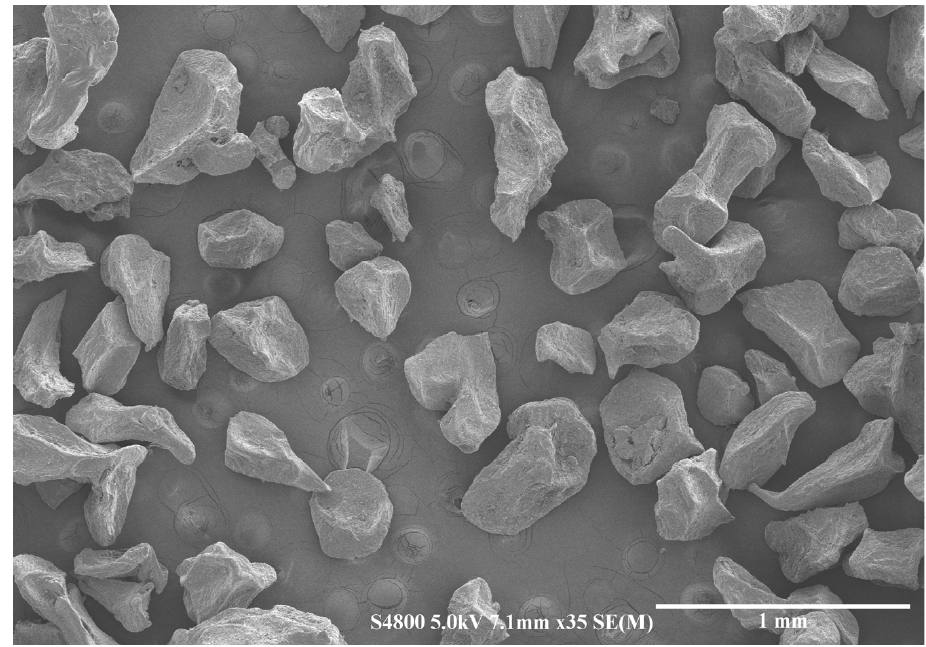
Figure 1. SEM image of alginate–chitosan microcapsules.